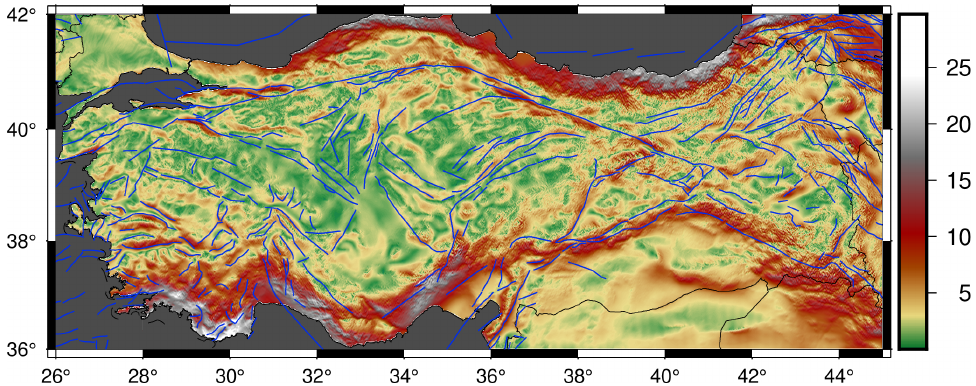
Figure 10. Slope of the geoid heights computed with the gravimetric geoid model (expGeoid-6). Units are percentages. The active faults were taken from the Global Active Faults Database